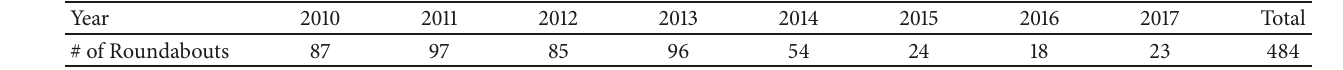
Table 1: Number of roundabouts constructed since 2010 in Korea.